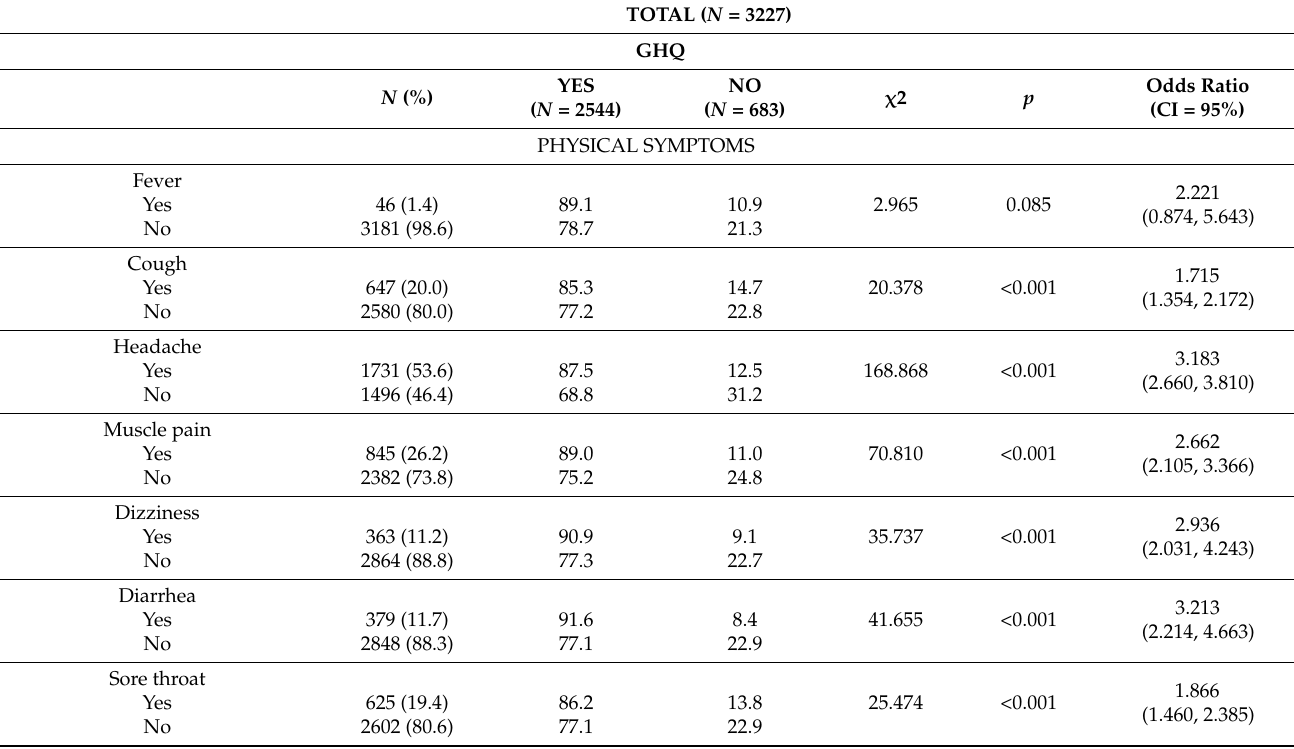
Table 3. Association between self-perceived health, physical symptoms, and other health variables related with psychologi- cal distress during the COVID-19